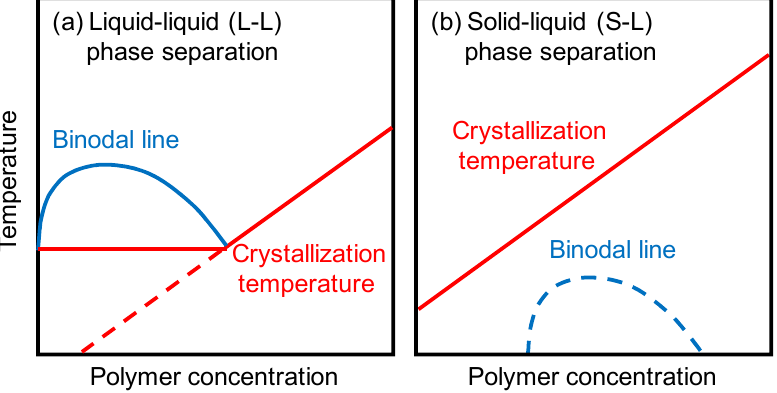
Figure 1. Phase diagrams in the thermally induced phase separation (TIPS)